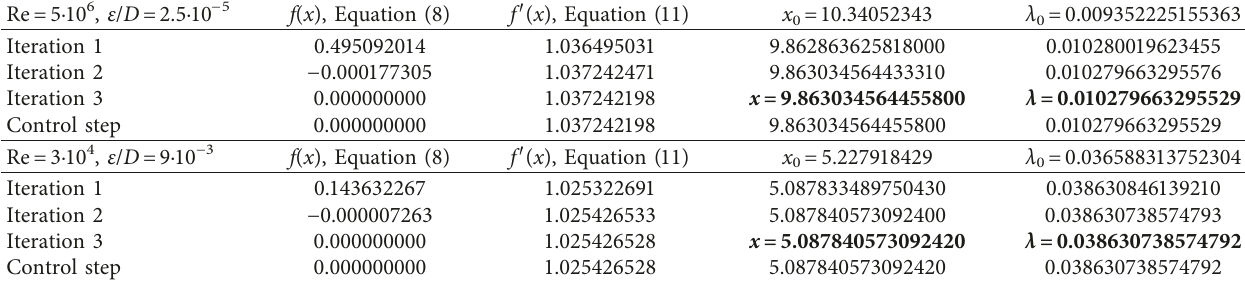
Table 4: Newton–Raphson procedure. Option 4: starting point x through the transmission factor x : Equation (12), and the symbolic derivative f ′ ( x ): Equation (11). Re � 5 · 10 6 , ε / D � 2.5 · 10 −